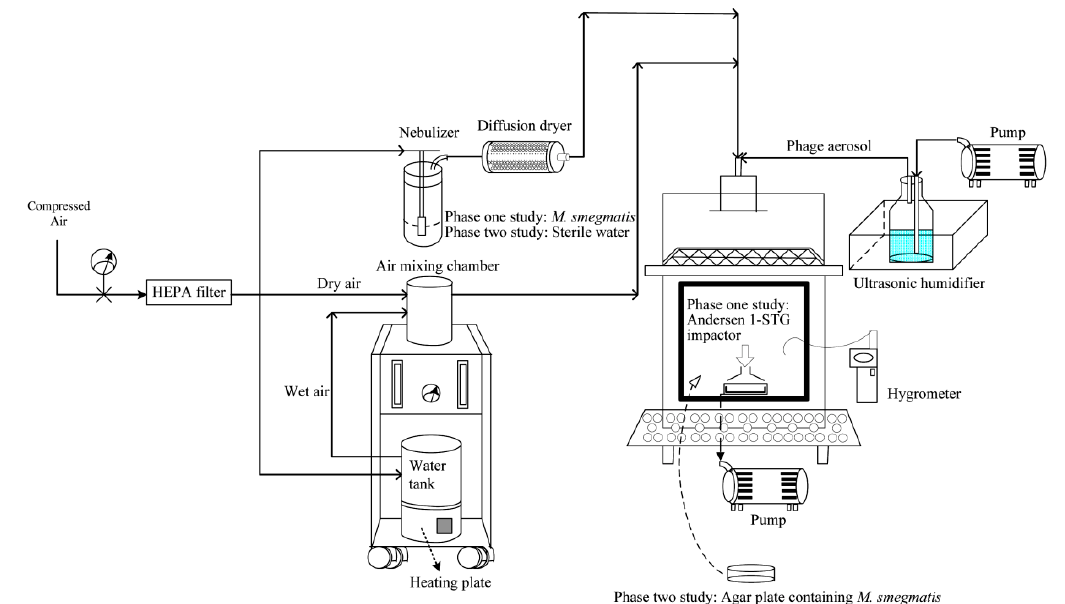
Figure 1. Schematic diagram of the bioaerosol test system for ( a ) collection efficiency of tested bioaerosol samplers for collecting airborne M. smegmatis , ( b ) reduction of airborne M. smegmatis by ϕ BTCU-1 aerosols (phase one study), and ( c ) the bactericidal effect of ϕ BTCU-1 aerosols on M.